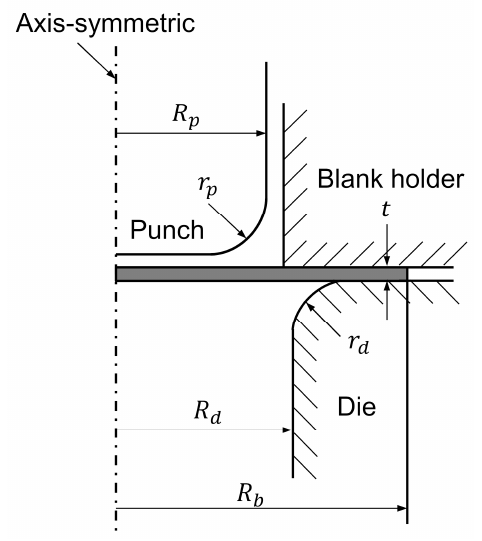
Figure 1. Schematic diagram of the axis-symmetric deep drawing process.